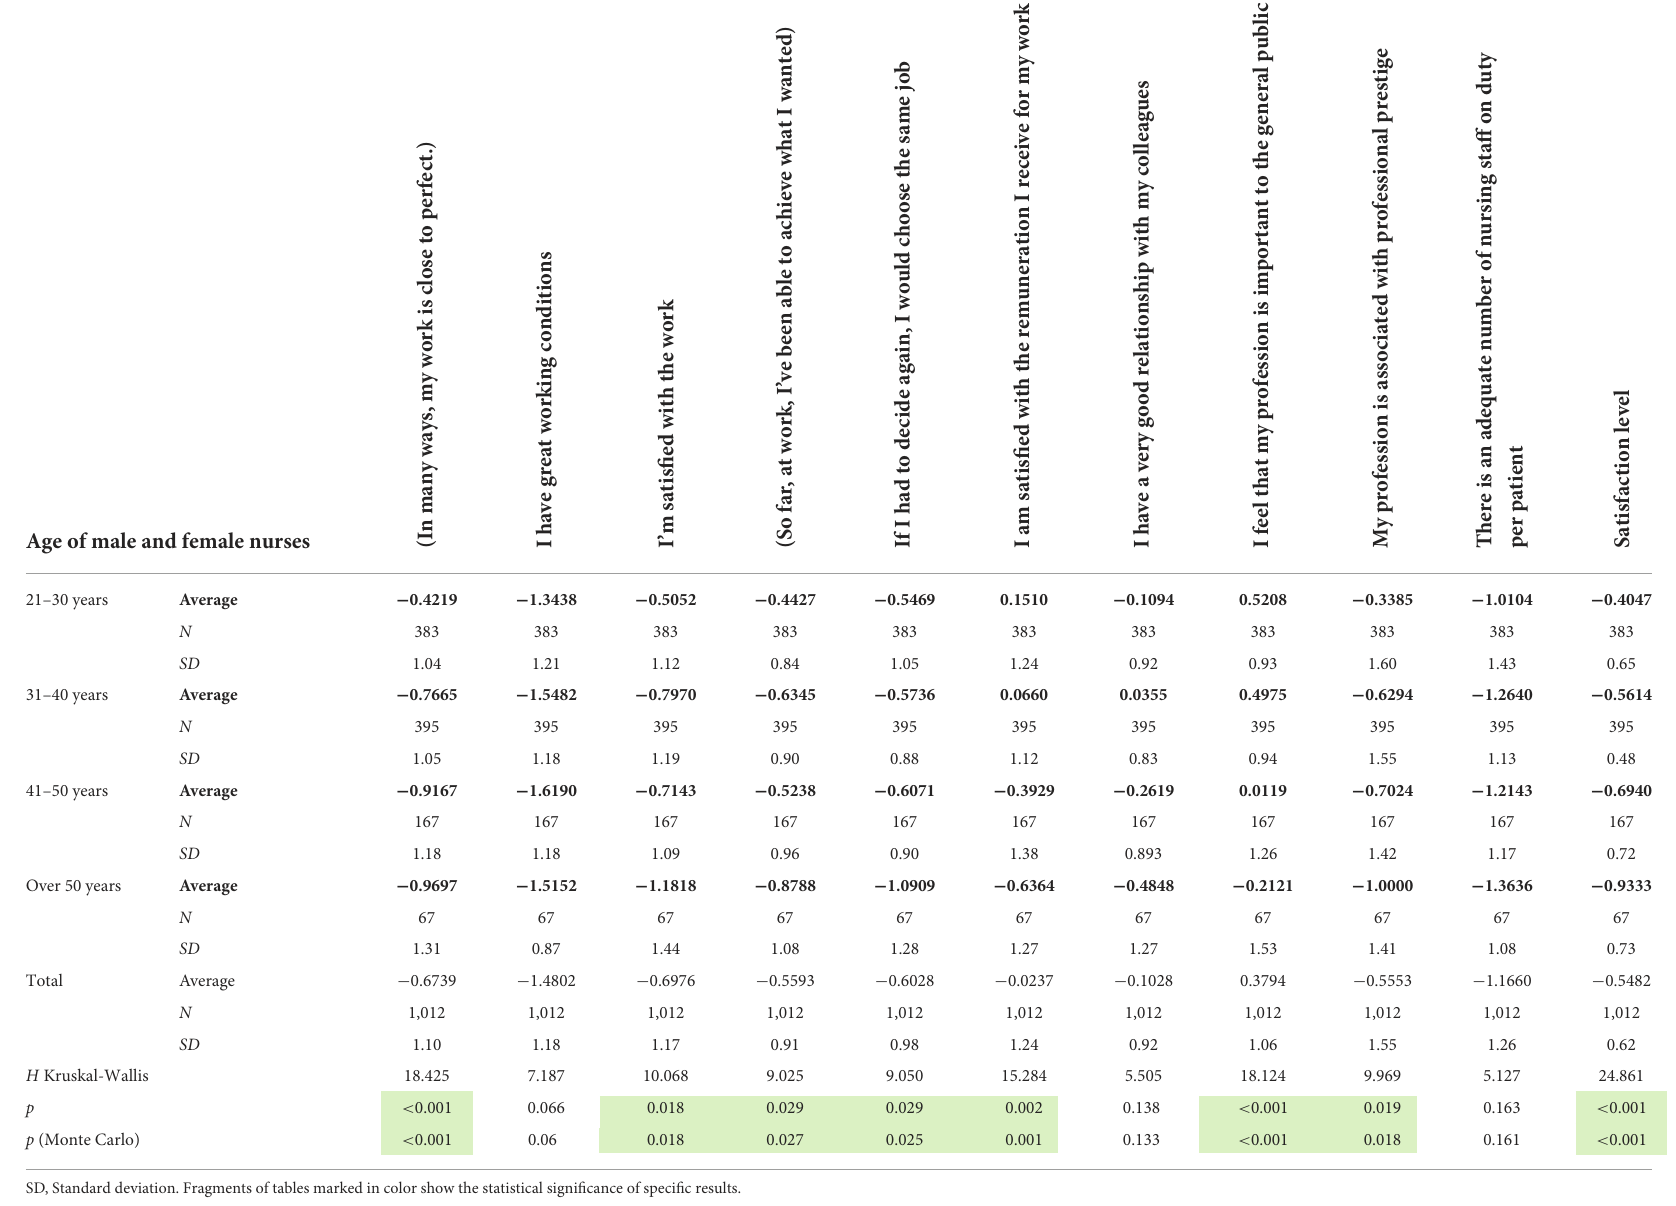
TABLE 6 Change in satisfaction with professional work during the COVID-19 pandemic and the age of the surveyed group.